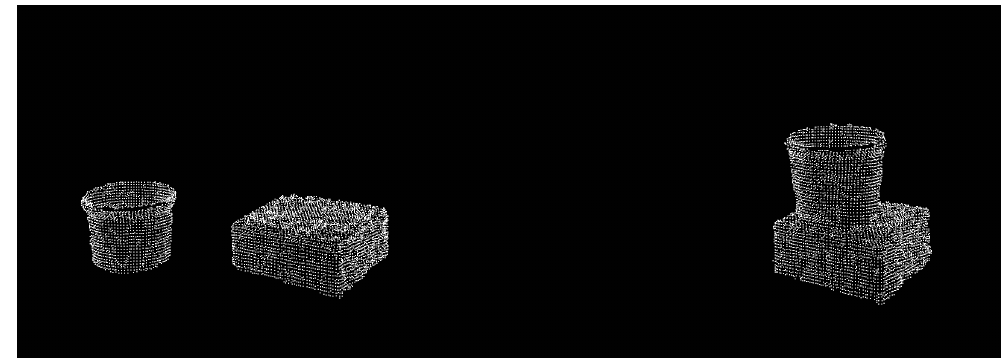
Figure 6. Point clouds (pre-processed) of the item stacking task. Left : before the demonstration, right : after the demonstration.